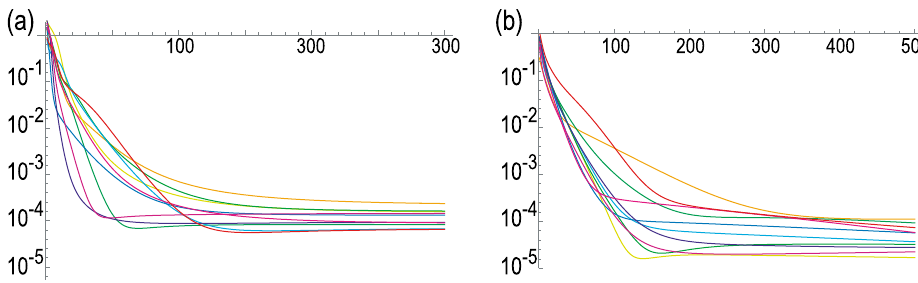
Figure 3. Evolution of the cost function for ( a ) two qubits and ( b ) three qubits. The vertical axis is the log 10 E cost . The horizontal axis is the number of variational steps. We use c 1 = 0.005 and c 2 = 0.005 for